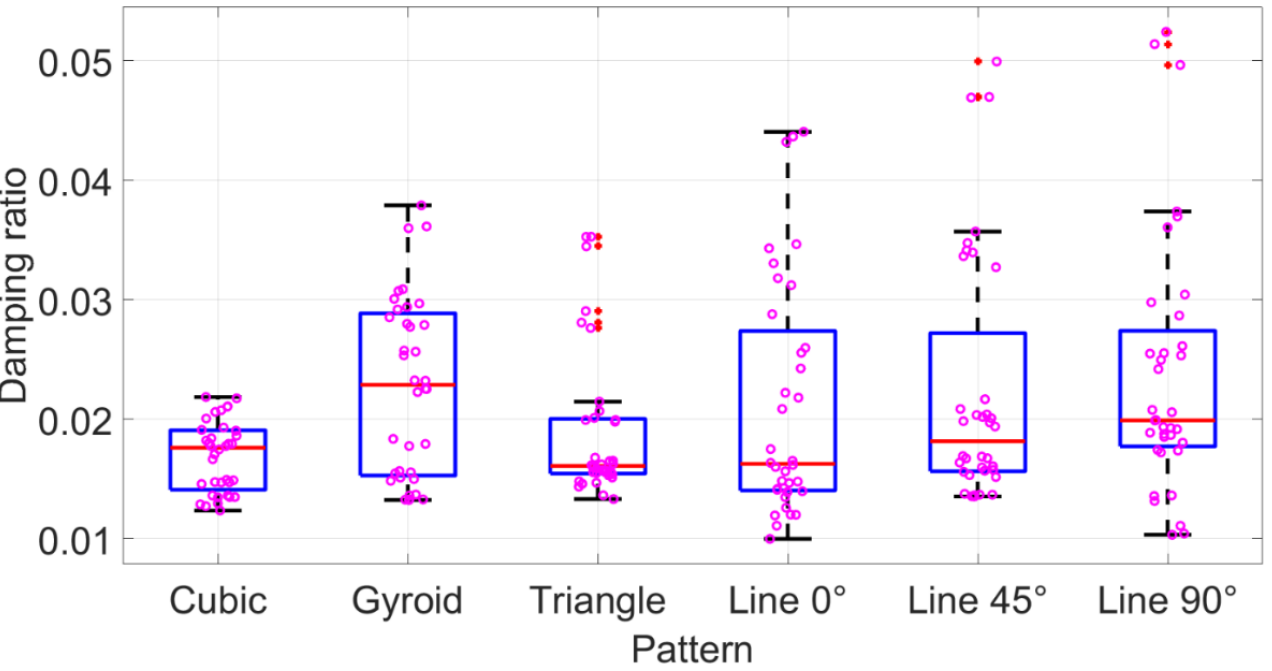
Figure 5. Damping factor box plots for infill pattern. Red dots are outliers. Violet circles are raw data.